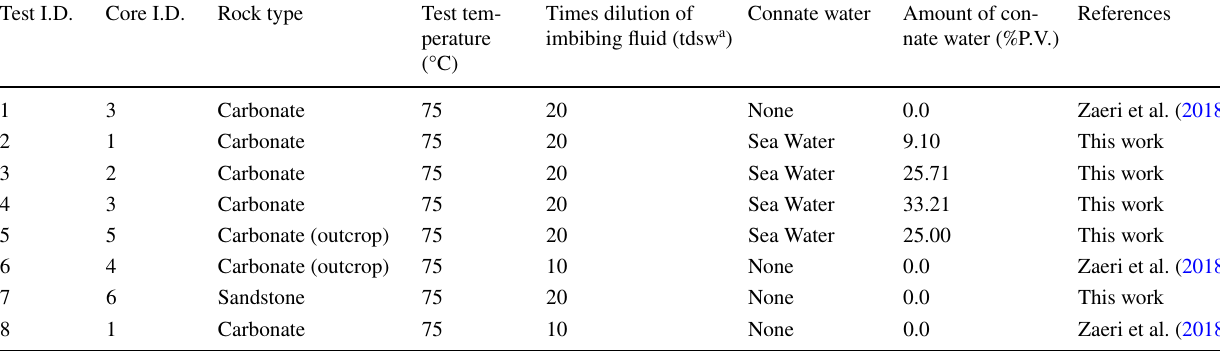
a Times diluted sea